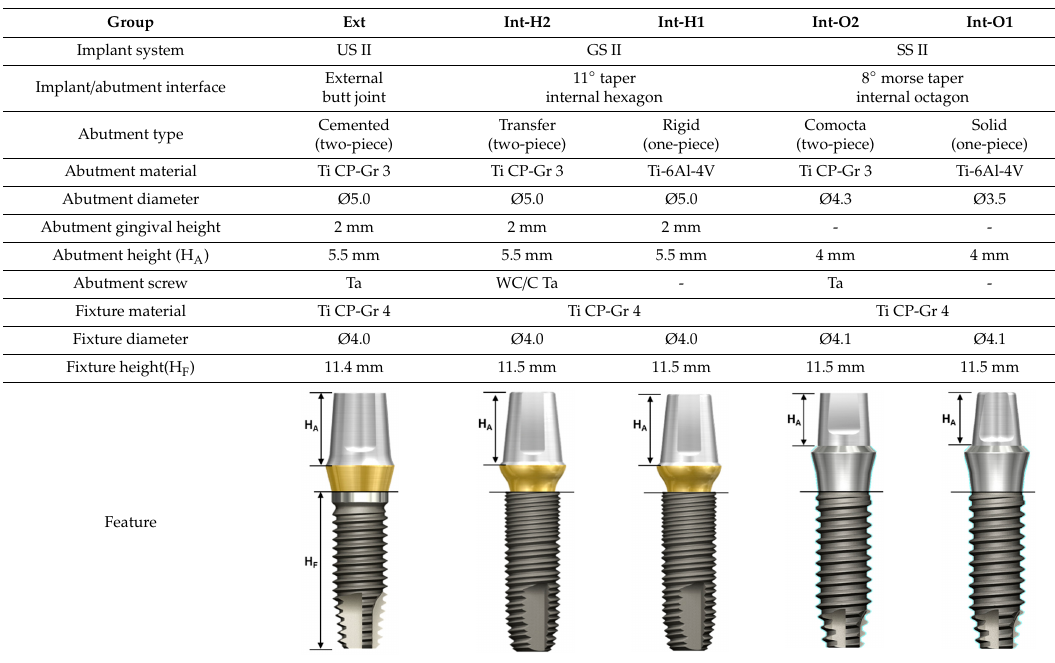
Table 1. Characteristics of experimental implant-abutment systems.